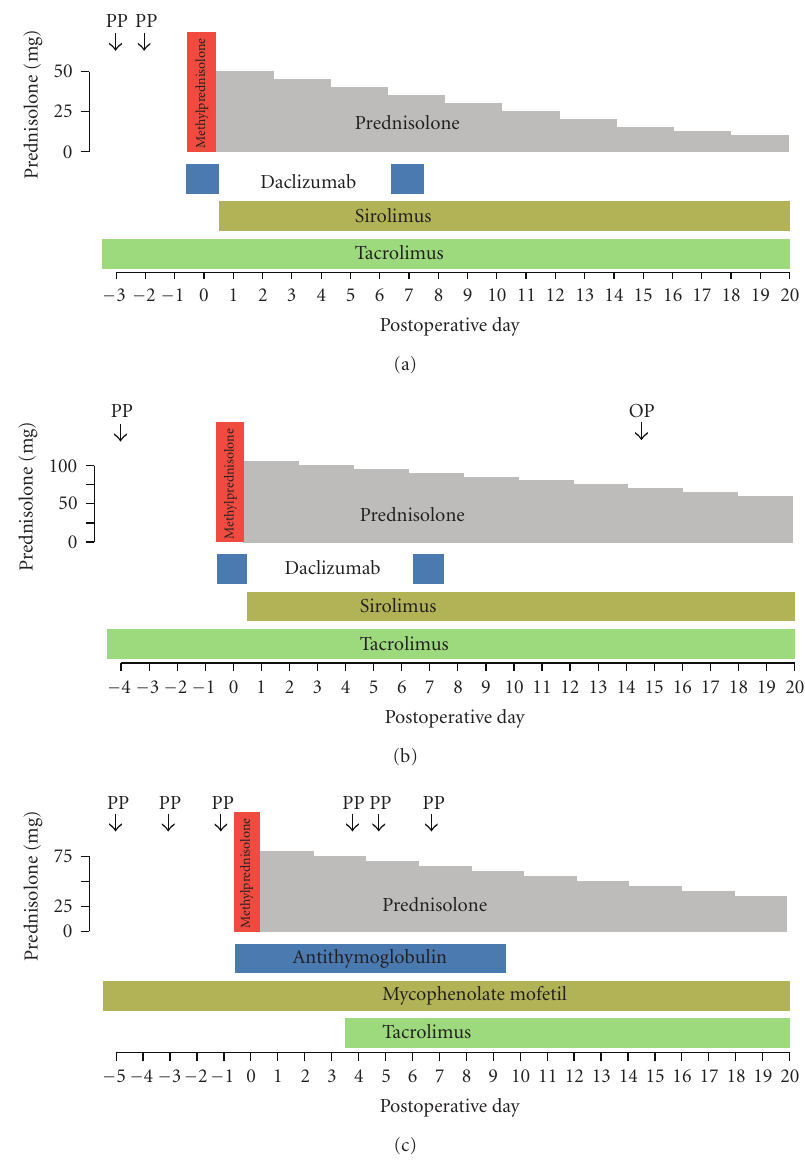
Figure 1: Immunosuppressive regimens of patients 1, 2, and 4 (panels (a)–(c), resp.) from the day of first preoperative treatment until postoperative day 20. Arrows indicate plasmapheresis or immunoadsorption; grey, green, and khaki colored areas correspond to maintenance therapy with prednisolone, tacrolimus, and adjuvant immunosuppression, respectively; blue and red area corresponds to induction treatment with daclizumab (100mg at ALDLT and 50mg on the seventh postoperative day) or antithymocyte globulin (1.5mg per kilogram body weight) for 10 days and methylprednisolone (500 mg), respectively. PP: plasmapheresis; OP: